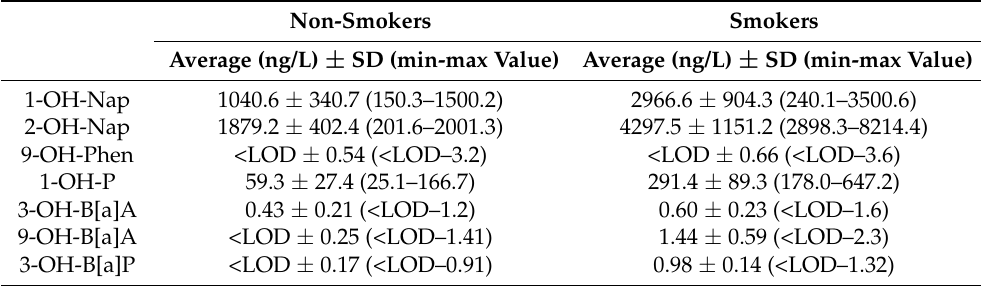
Table 3. OH-PAHs in human urine of smokers and non-smokers. (SD = standard deviation).